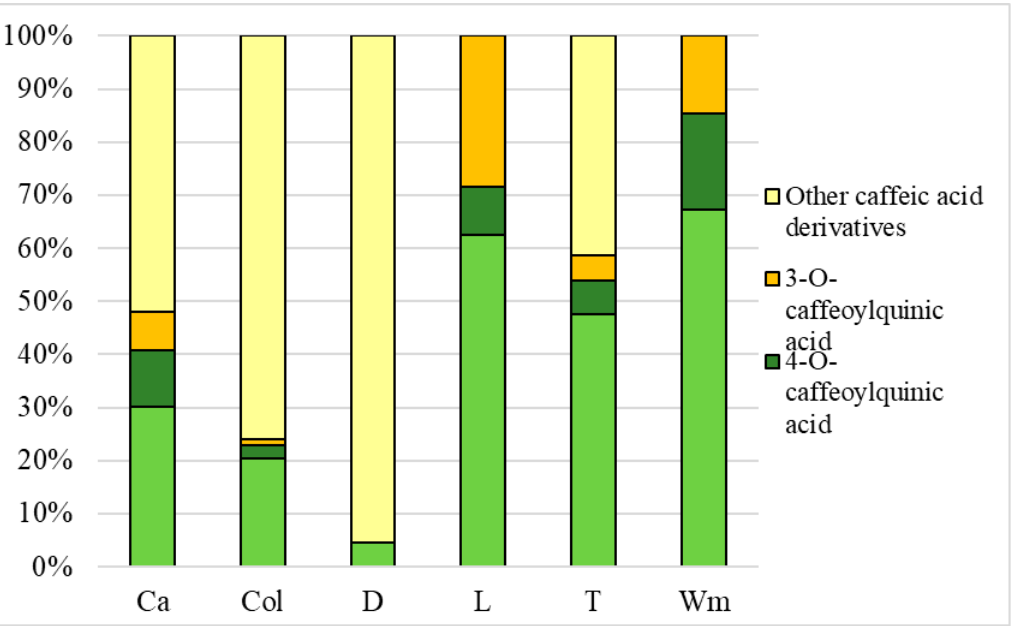
Figure 4. Percentage concentration of caffeic acid derivatives in water-ethanolic extracts. Ca—caraway; Col—Coltsfoot; D—dandelion; L—lovage; T—tarragon; Wm—white mulberry;